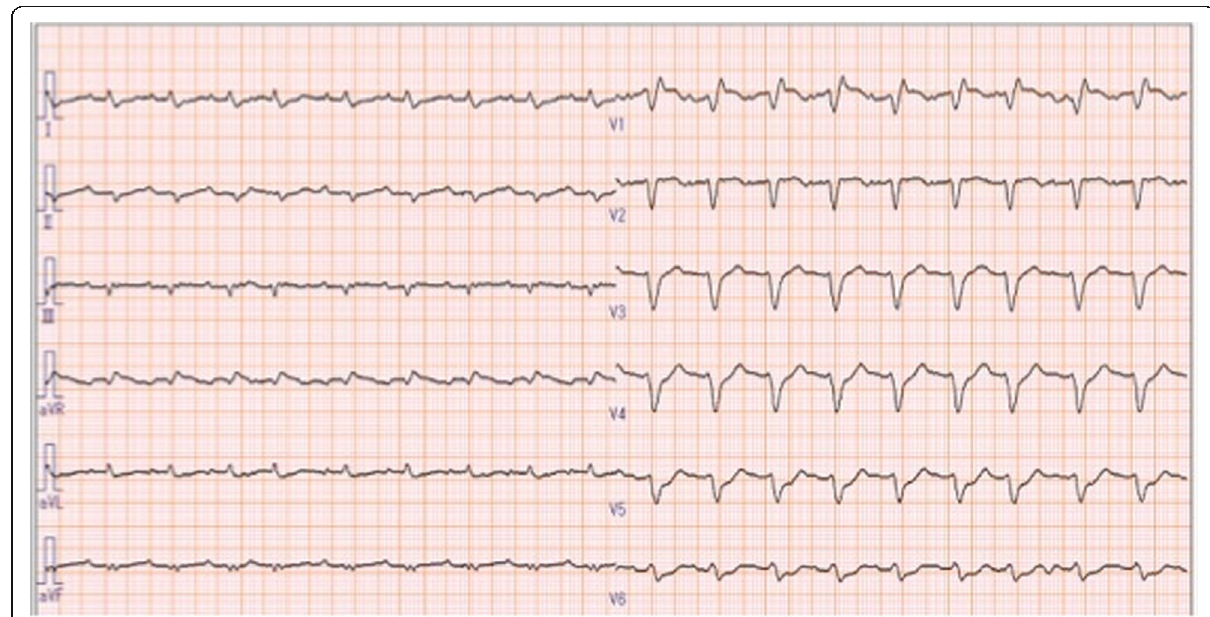
Fig. 1 The 12-lead electrocardiogram of the patient upon admission to the intensive care unit. Sinus rhythm, low-voltage R-wave, and intraventricular conduction disturbance in all leads were